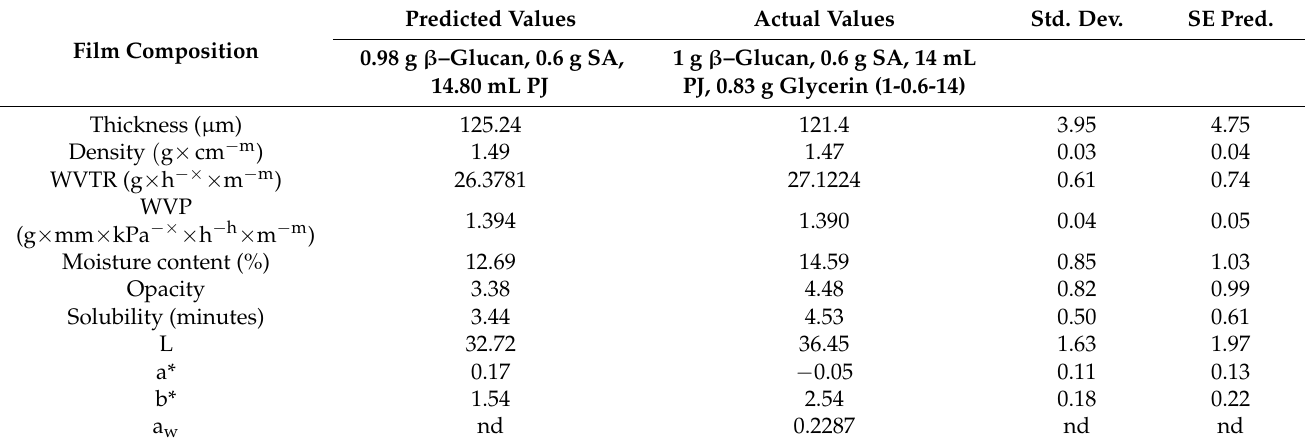
Table 7. Predicted vs. actual values of the optimal film sample.